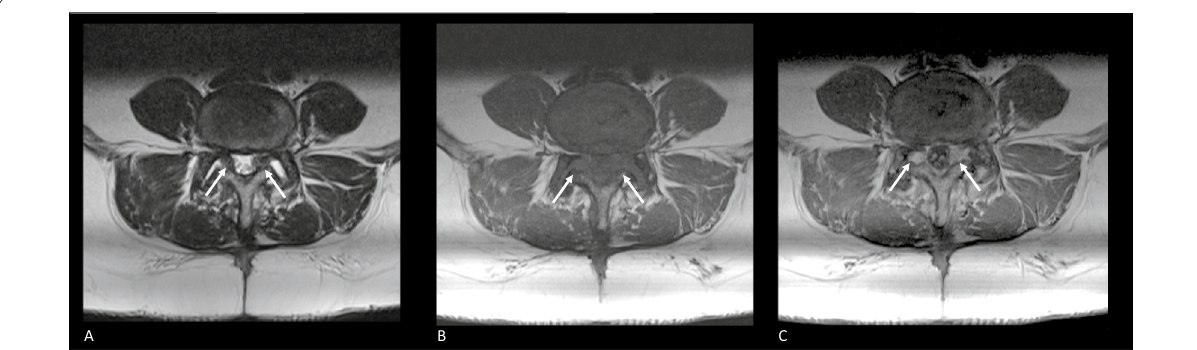
Fig. 8 Axial MRI of the postoperative lumbar spine at level L4–L5. A Axial T2-weighted image showing soft tissue occupying the subarticular zone bilaterally. Tissue shows to have an intermediate signal intensity. Cauda equina roots are displaced and course more central in the dural sac. B Axial T1-weighted image showing the tissue characteristics of the known soft tissue in the bilateral subarticular zone. On native T1-weighted images, an intermediate signal intensity is observed. C Post-contrast axial T1-weighted image showing homogeneous enhancement of the known soft tissue in the subarticular zone bilaterally. Based on this enhancement, a suggestion of postoperative epidural fibrosis was